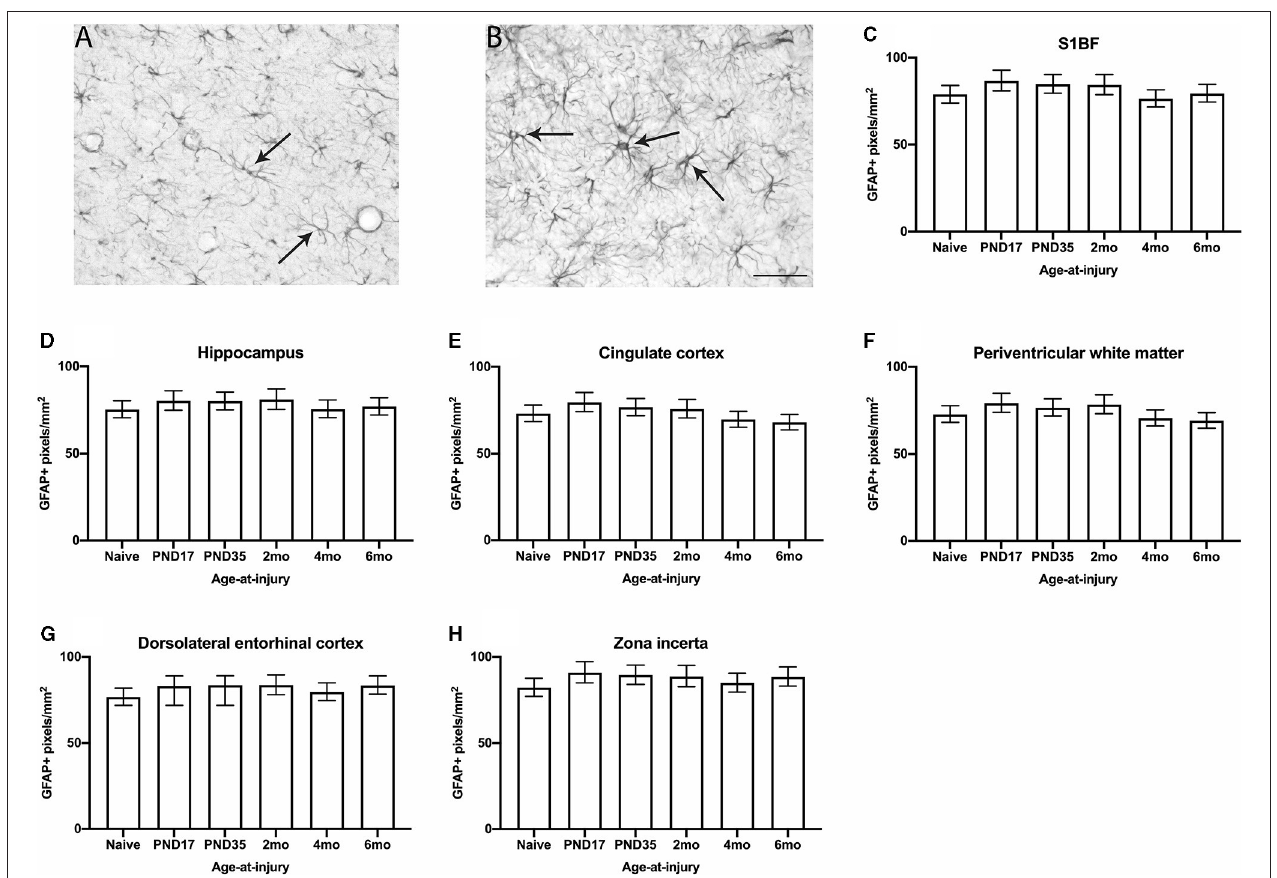
FIGURE 5 | GFAP immunoreactivity was quantified in the S1BF, hippocampus, cingulate cortex, periventricular white matter, dorsolateral entorhinal cortex, and zona incerta. Representative images of ramified (A) and hypertrophic (B) astrocytes, indicated with black arrows (scale bar = 50 µ m), visualized by GFAP immunohistochemistry were taken in the primary sensory barrel field (S1BF) of rats injured at 6-months of age. The expression of GFAP increases when astrocytes become hypertrophic and, thus, activated. Therefore, the extent of GFAP immunoreactivity is used as a measure of astrocyte activation and is expressed as the number of GFAP-positive pixels/mm 2 (mean ± 95%CI) in the S1BF, hippocampus, cingulate cortex, lateral ventricle, dorsolateral entorhinal cortex, and zona incerta. There were no significant differences in the percentage of GFAP + profiles observed following mFPI, regardless of age-at-injury, compared to naïves in the S1BF (C) , hippocampus (D) , cingulate cortex (E) , periventricular white matter (F) , dorsolateral entorhinal cortex (G) , or the zona incerta (H)